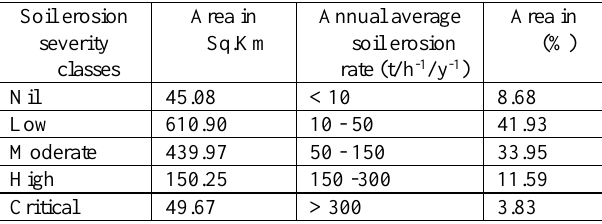
Table 1. Soil erosion severity classes with average annual soil erosion rate